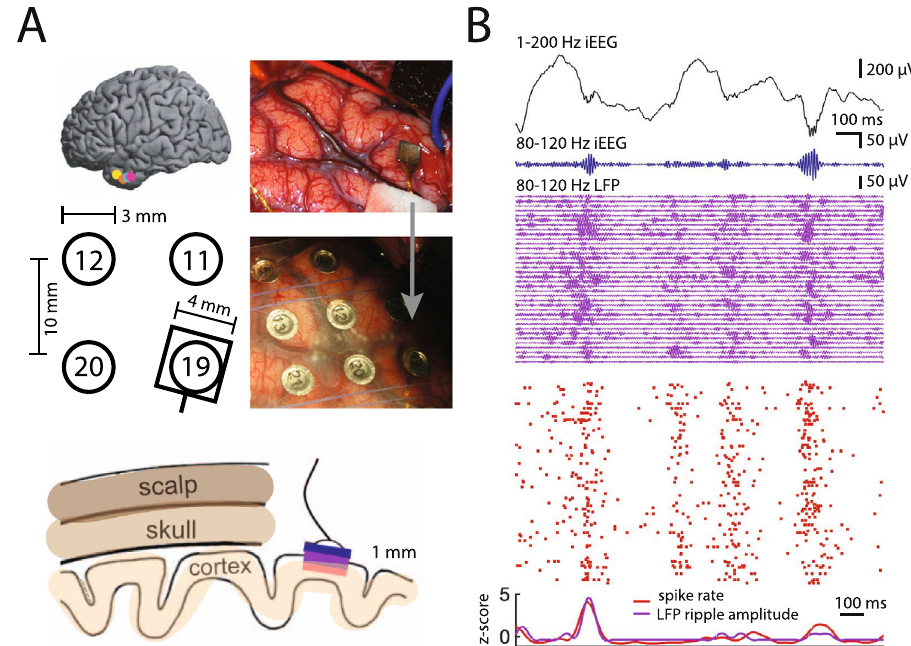
the cortical surface and one array in cortex. B 1500ms window of 1 – 200Hz iEEG